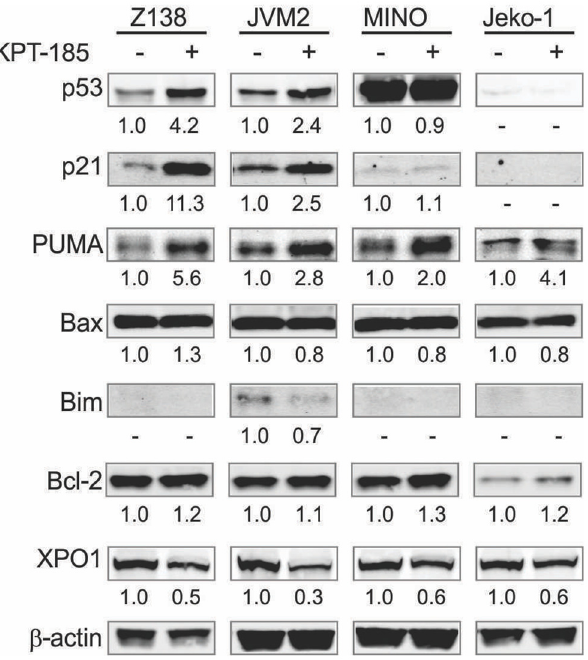
Fig 2. KPT-185 modulates XPO1 and Bcl-2 family members in MCL cells. After an 18-h treatment with KPT-185 (50 nM for Z138, 200 nM for JVM2, MINO and Jeko-1), cells were lysed and analyzed by immunoblot. The results are representative of three independent experiments, and the intensity, compared to that of β -actin, of the immunoblot signals was quantified using ImageJ